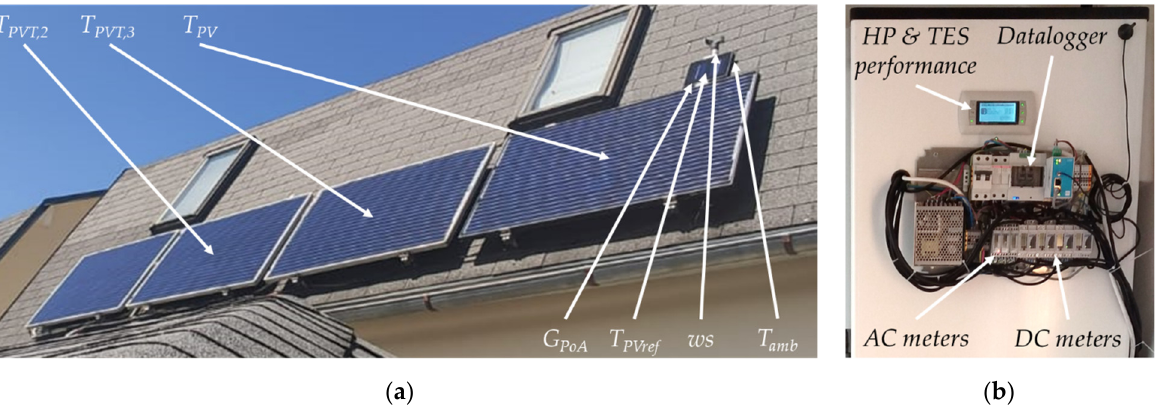
Figure 5. Sensors distribution in the prototype under test: ( a ) Local meteorological conditions, PVT collectors and PV module operation temperatures; ( b ) Indoor instrumentation integrated in the front of the HP unit. Table 4. A selection of the most significant monitored variables, including the instrument used for the measurement and some additional relevant